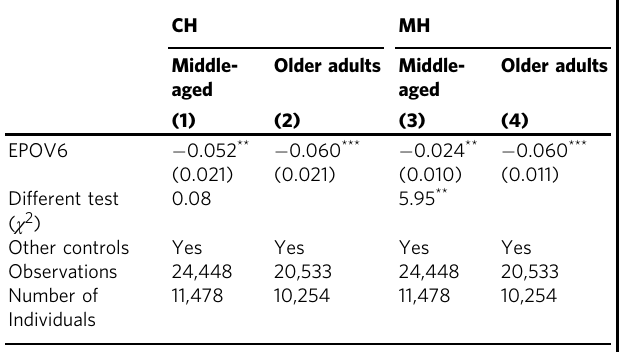
Table 9 Further investigation (heterogeneous effects across different